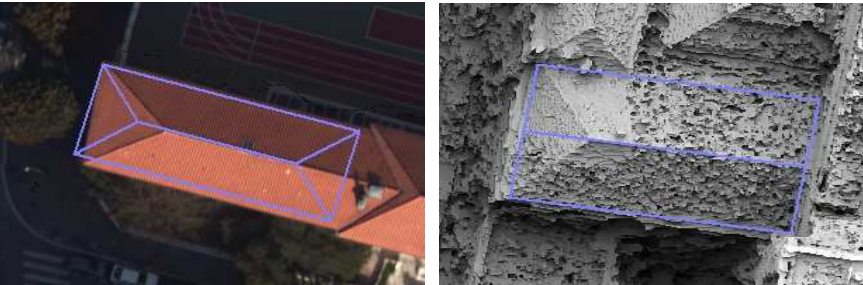
Figure 4. Some erroneous reconstructed buildings resulting from a known feature-based framework for massive building reconstruction (BATI- 3 D R (cid:13) prototype software—a large scale building modeling pipeline developed at the French National Geographical Agency). The estimated 3D models are projected onto the image or